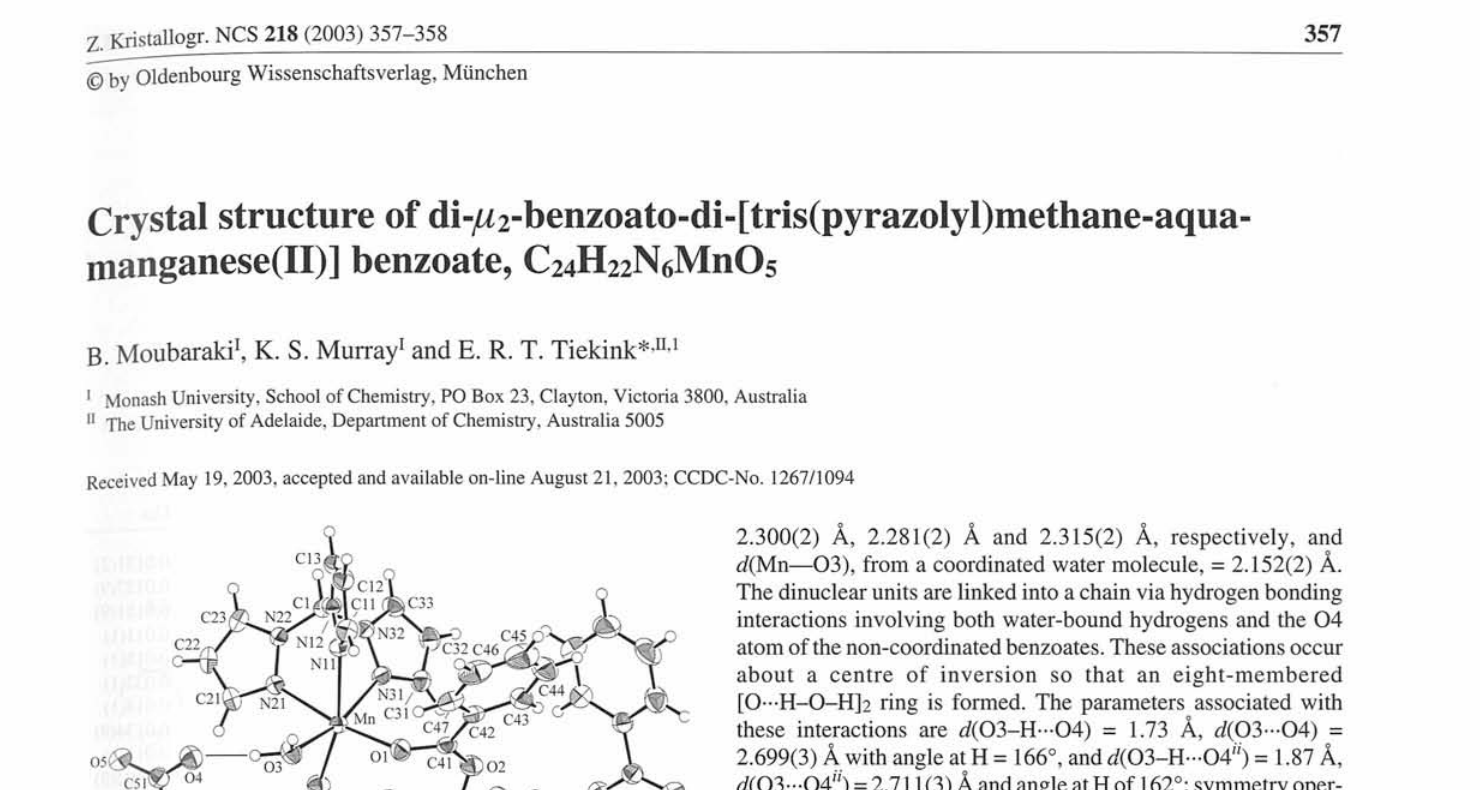
Table 1. Data collection and handling.